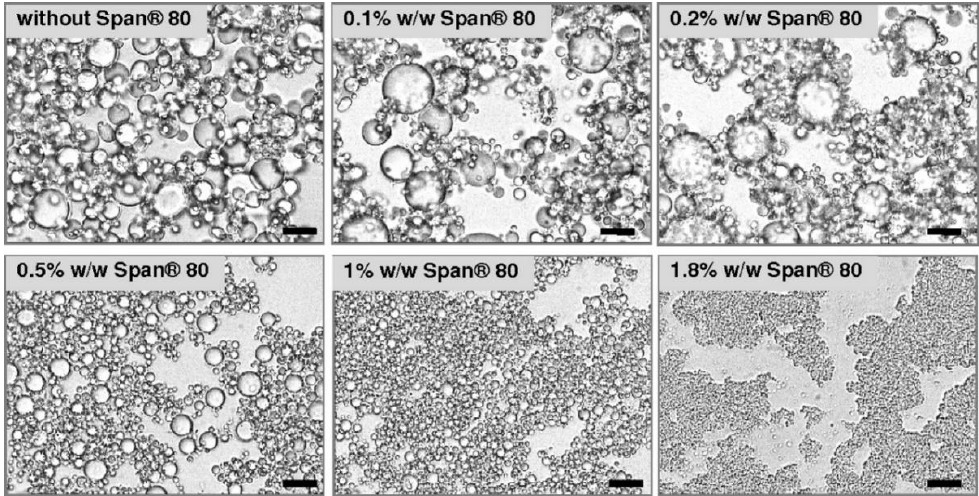
Figure 4. Optical microscopy images of W/O emulsions containing a paraffin oil and 1.8% ( w / w ) of silica particles and different concentrations of Span 80 surfactant [52] .